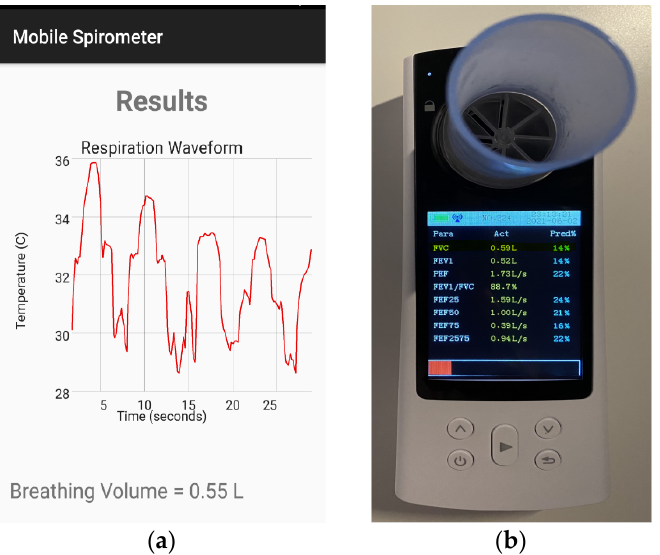
Figure 11. Measured normal breathing volume (tidal volume) ( a ) using the mobile application with a thermal camera and ( b ) using the conventional spirometer.